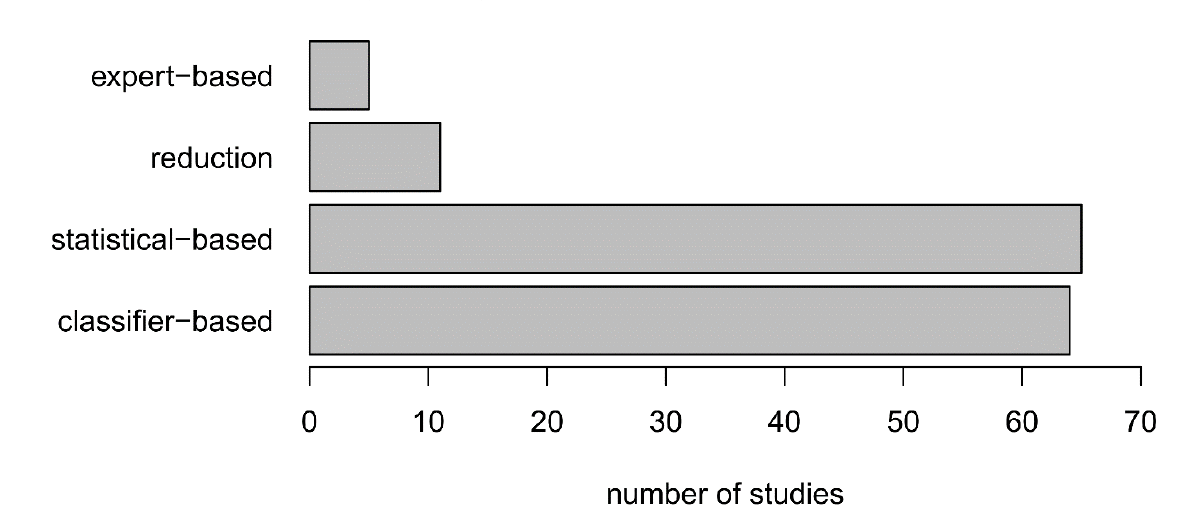
Figure 5. Number of studies reviewed by method used to consider correlated variables.